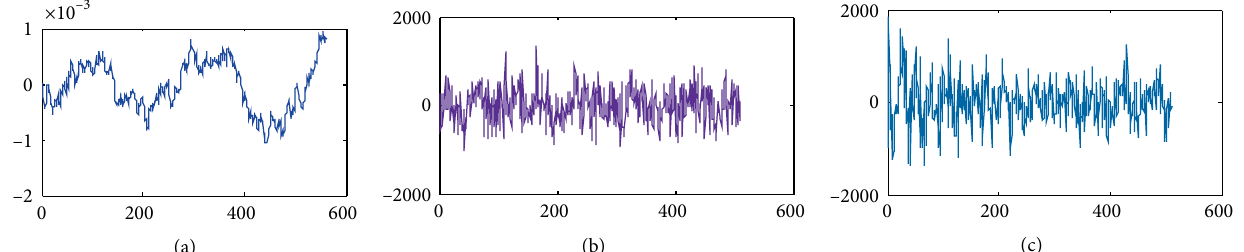
Figure 7: Key sensitivity on encryption process (a) original speech signal (b) encrypted speech signal for key , (c) encrypted speech signal for 𝑧 0 = 0.465 𝑤 0 = 0